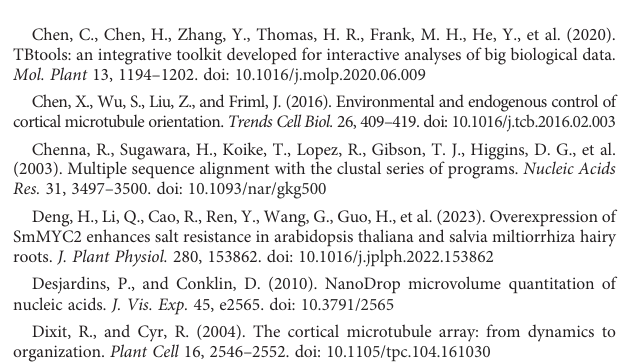
SUPPLEMENTARY TABLE 4 PtTPX2 gene expression